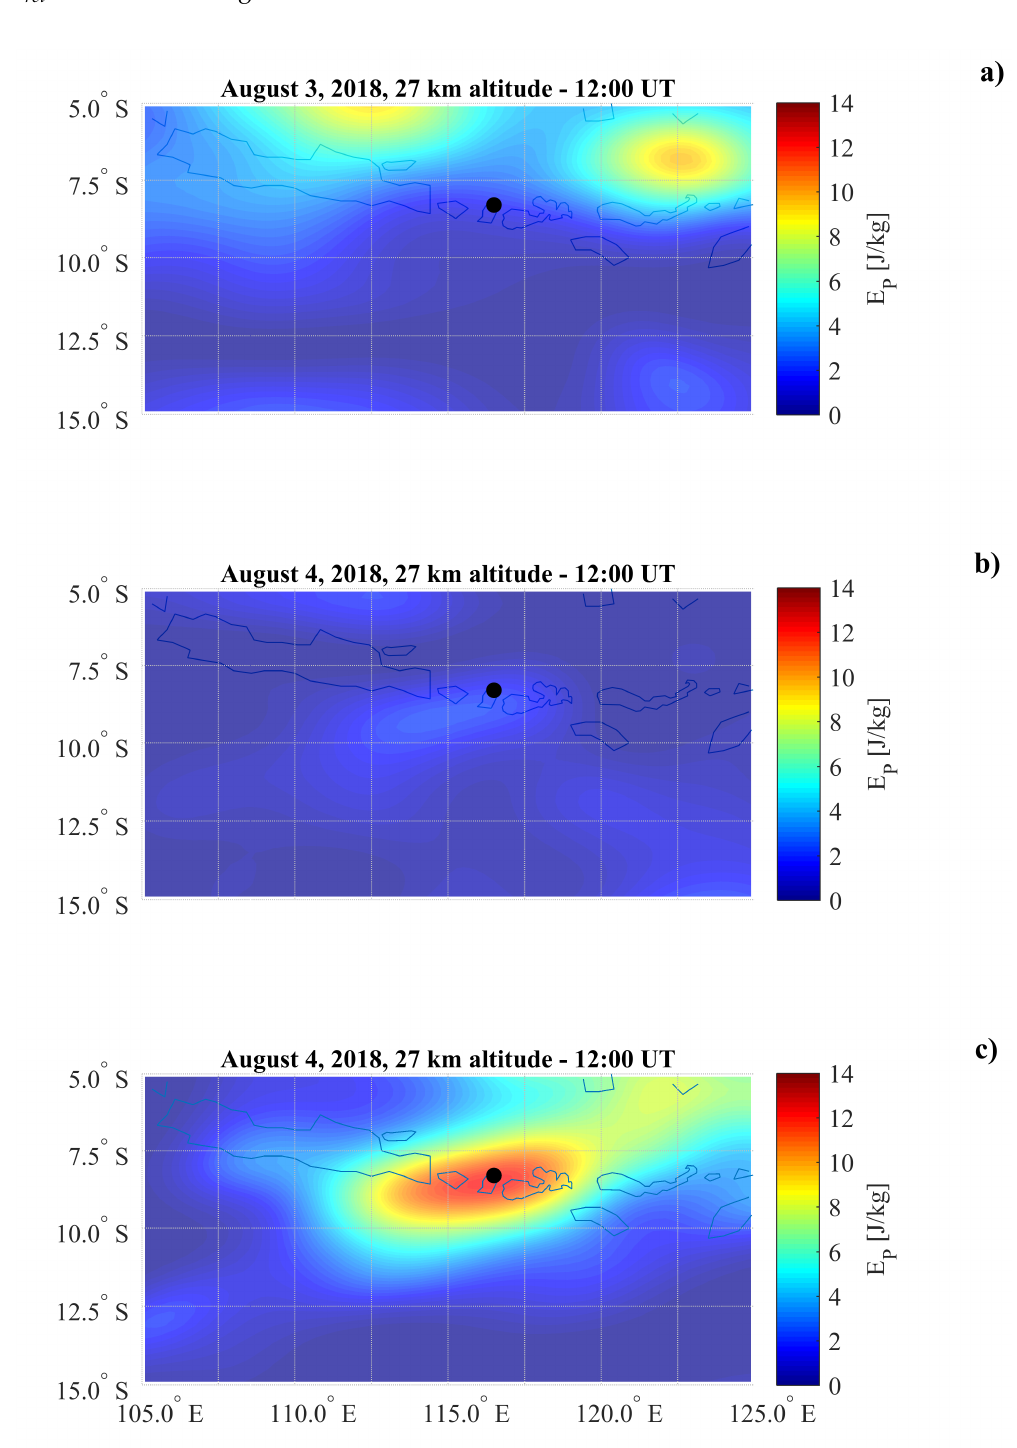
Figure 2. Co-seismic E P maps from 3 to 5 August 2018. The date and altitude are indicated in each panel ( a – c ). The earthquake epicenter is marked by a black